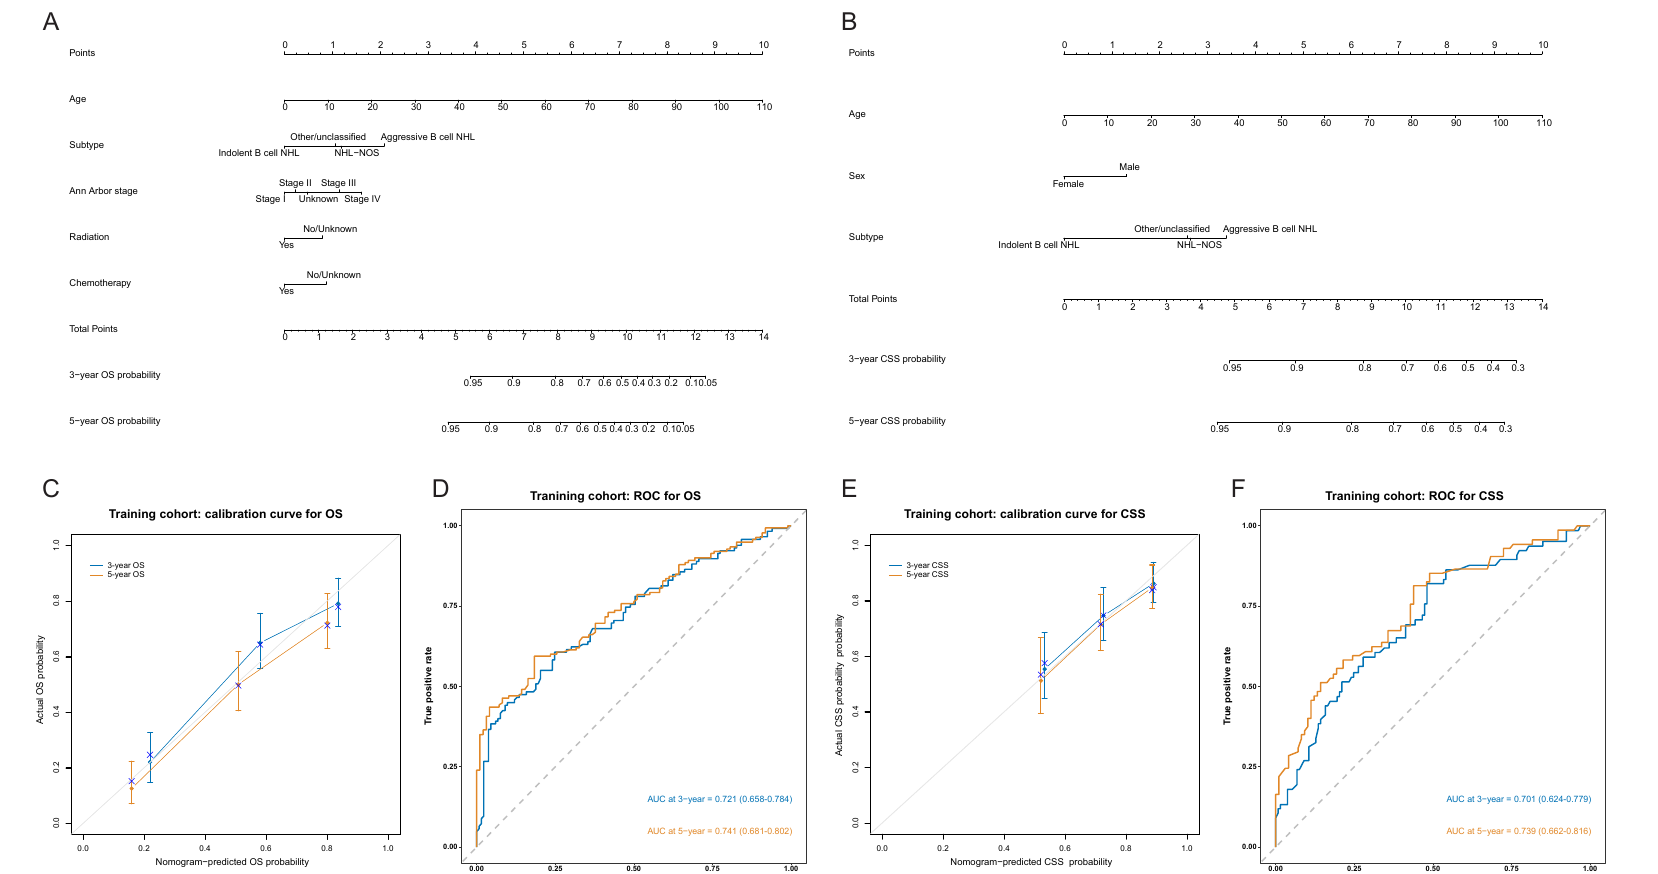
Figure 3. Nomograms to predict 3-year and 5-year OS ( A ) and CSS ( B ) of patients with primary bladder lymphoma, and calibration curves and ROC of the OS nomogram ( C , D ) and CSS nomogram ( E , F ) in the training cohort. The AUC at 3-year (the blue line) and 5-year (the orange line) was 0.721(95% CI, 0.658–0.784) and 0.741(95% CI, 0.681–0.802) for the OS nomogram, and 0.701 (95% CI, 0.624–0.779) and 0.739 (95% CI, 0.662–0.816) for the CSS nomogram. NHL, non-Hodgkin’s lymphoma; NOS, not otherwise specified; OS, overall survival; CSS, cancer-specific survival; ROC, receiver operating characteristic curve; AUC, areas under the